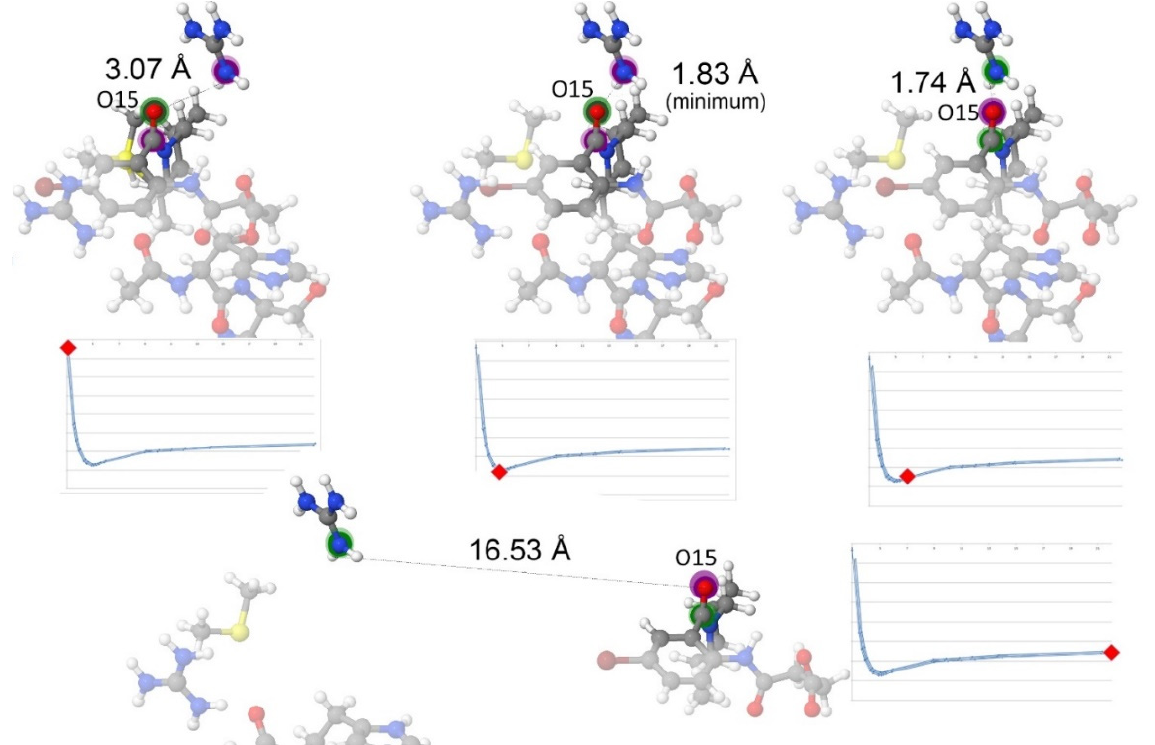
Figure 5. The so-called neighbour effect illustrated for four configurations, each marked by an inset representing the full wave function energy profile (blue) with a red diamond marking that particular configuration. The atoms involved in hydrogen bonds, namely the hydrogen donor (N48 in Arg501) and hydrogen acceptor (O15 in the amide of the ligand), show opposite behaviours to each other. The opposite behaviour between the hydrogen donor and the hydrogen acceptor is maintained once past the global minimum and entering segment 2. After transitioning the segment, the behaviour of these two atoms remains opposite to each other, but they now contribute to the whole system in a switched sense, as marked by the coloured circles shown surrounding the atoms. The green circles surrounding an atom represent increased stability (a more negative energy), while the purple circles represent decreasing stability (a less negative energy). We travel along the energy profile from left to right (i.e., the ligand moves away from the pocket). Initially, the hydrogen acceptor O15 is shown surrounded by a green circle, as its energy becomes more negative until the global minimum. When the distance increases further, away from the global minimum, segment 2 starts and the energy of O15 becomes less negative as the distance increases. Meanwhile, the hydrogen donor (N48 in Arg501) and the neighbour (carbon of the amide of the ligand) of the hydrogen acceptor show opposite behaviour. The hydrogen atom itself from the hydrogen bond can make a contribution in both senses depending on the case, although the REG value will be small and often not rank as an important contributor.